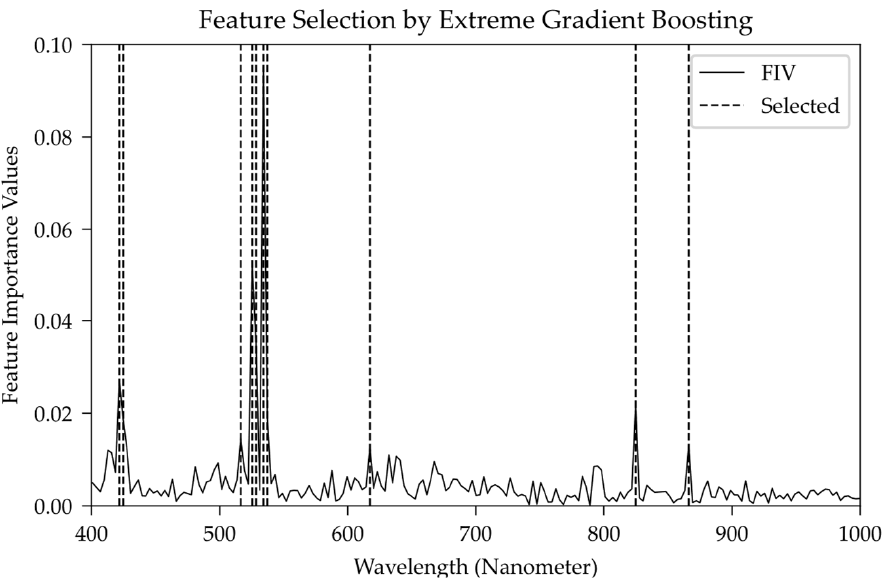
Figure 4. All bands’ FIV values and the selected ten crux bands.